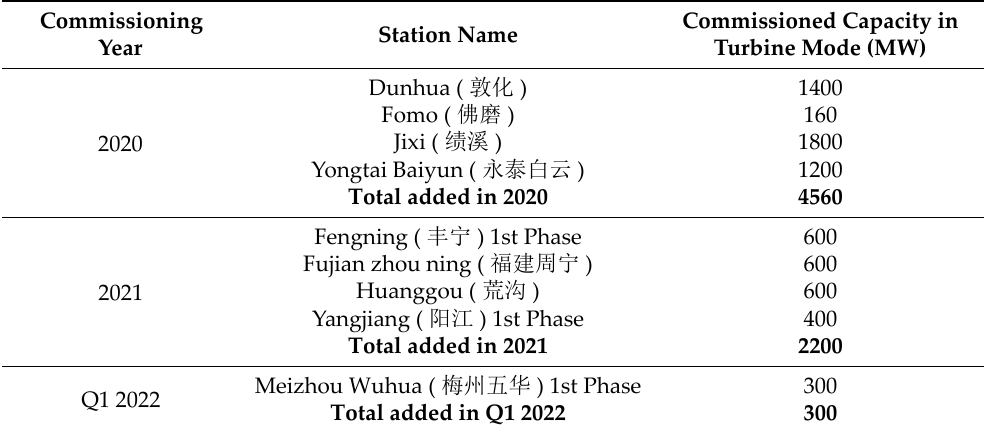
Table 3. New commissioned PHS capacity (in terms of turbine operation mode). From 2019 (namely 2020) to the first quarter of 2022. Plants are also presented by their Chinese name within brackets for